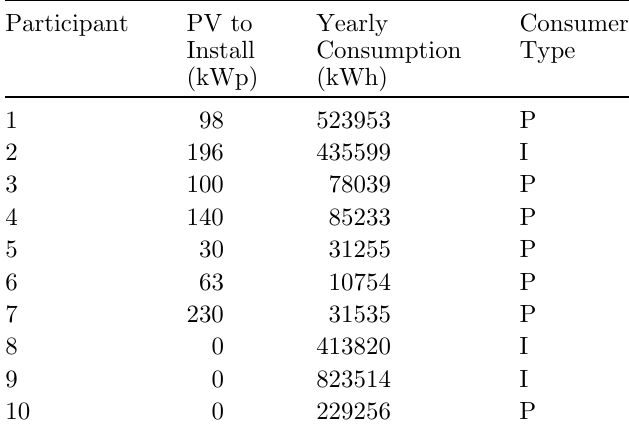
Table 1. Description of the participants of the Energy Community.